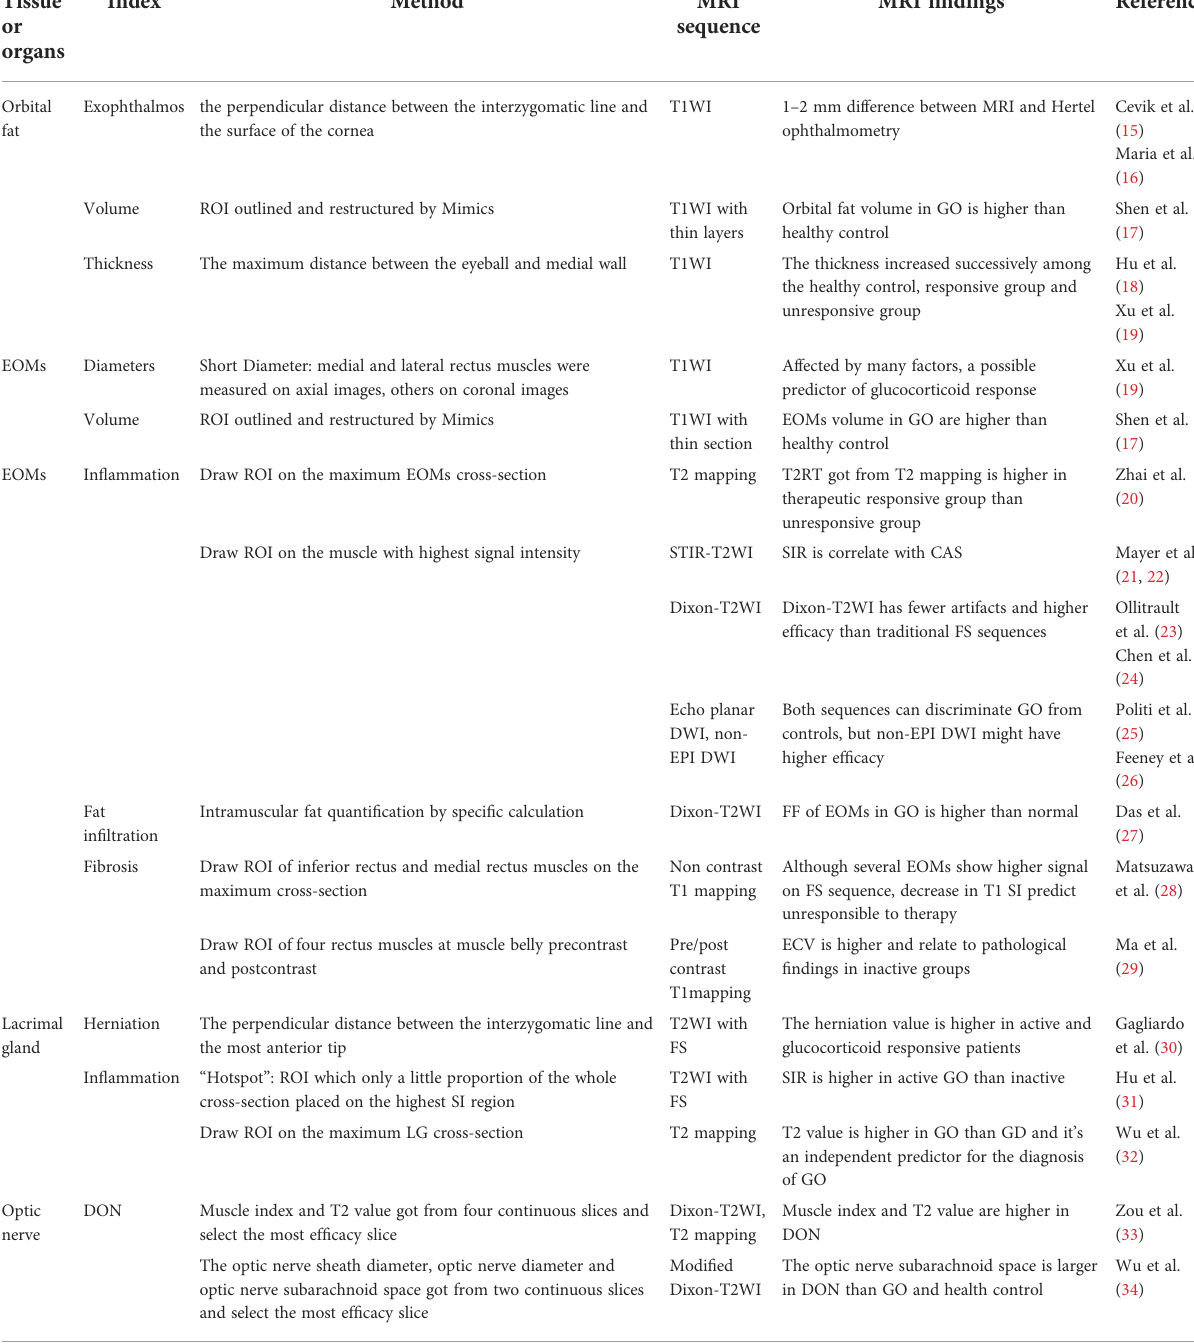
TABLE 3 MRI sequences applied in GO